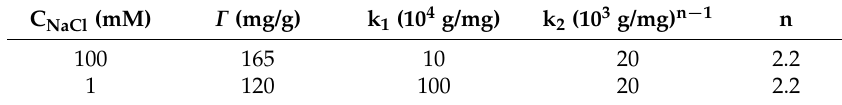
Table 1. The fit parameters for adsorption RhB onto SDS modified nano γ -Al 2 O 3 (SMNA).